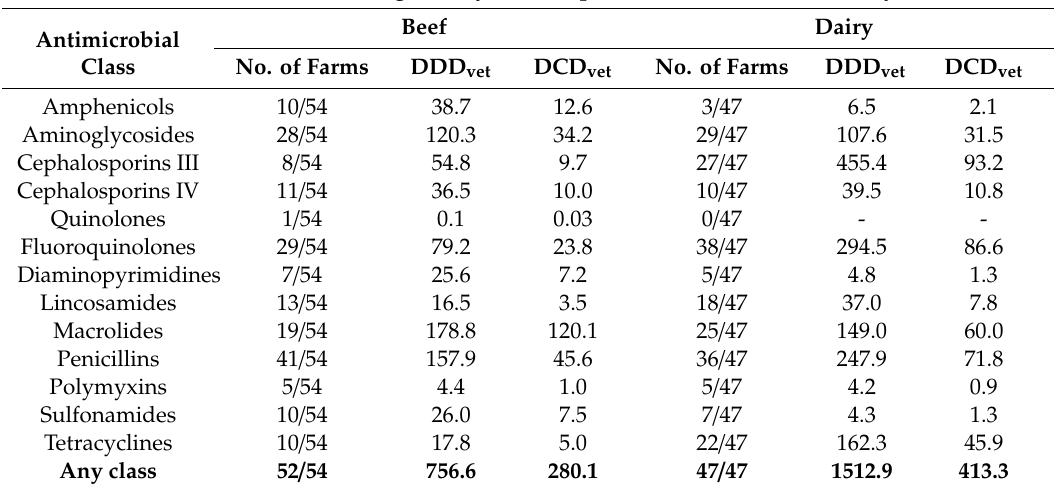
Table 1. Antimicrobial consumption (DDD vet / year × 10 − 3 − DCD vet / year × 10 − 3 ) by parenteral route per antimicrobial class and breeding category (for each administration route classes are listed only if they were part of at least one treatment performed on either beef or dairy